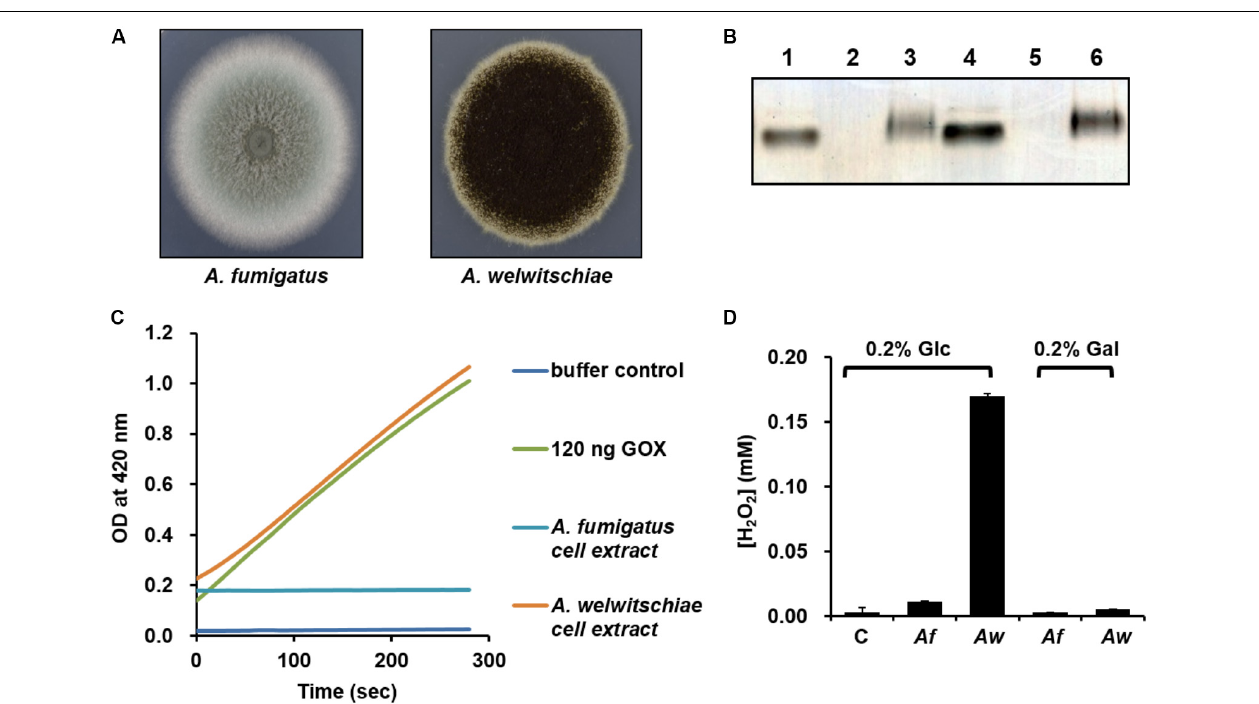
FIGURE 4 | Assay of glucose oxidase from Aspergillus strains and analysis of H 2 O 2 concentrations from Aspergillus culture supernatants. (A) Colonies of Aspergillus fumigatus and A. welwitschiae isolated from the natural habitat of the V. vulnificus CMCP6 strain. (B) In-gel glucose oxidase assay on a 16.5% poly-acrylamide gel containing entrapped peroxidase. Lanes 1 and 4, Type X-S A. niger glucose oxidase (Sigma-Aldrich) as control (25 and 50 ng, respectively); lanes 2 and 5, A. fumigatus crude extract (15 and 30 µ g proteins, respectively); lanes 3 and 6, A. welwitschiae crude extract (15 and 30 µ g proteins, respectively). (C) Glucose oxidase (GOX) activity was determined by a coupled enzyme assay, in which GOX oxidizes glucose resulting in the production of H 2 O 2 that reacts with o -dianisidine in the presence of peroxidase to form a colored product. The intensity of the brown color was measured at 460 nm. (D) The H 2 O 2 levels in M9S media containing glucose or galactose after overnight culture of A. fumigatus ( Af ) and A. welwitschiae ( Aw ). C, M9S medium without fungi. The results are presented as the mean ± standard deviations ( n =